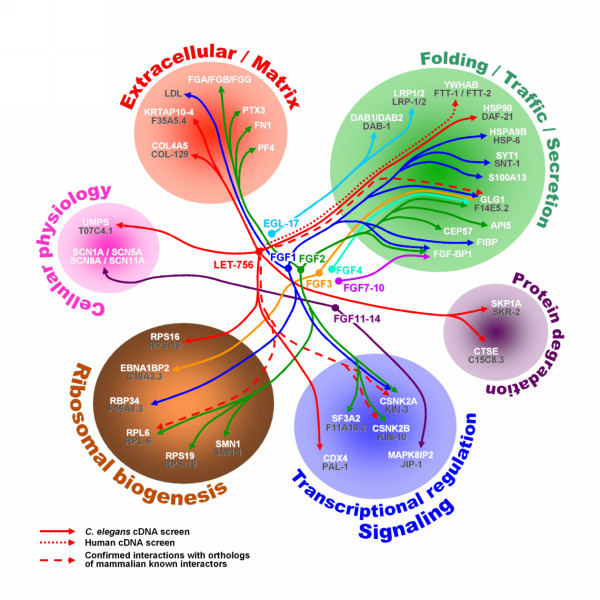
Interactome of the FGF family The identified interactors of various FGFs were grouped in six categories, depending of the functional activities of proteins. The human and C. elegans orthologs are indicated: human (white), worm (grey).